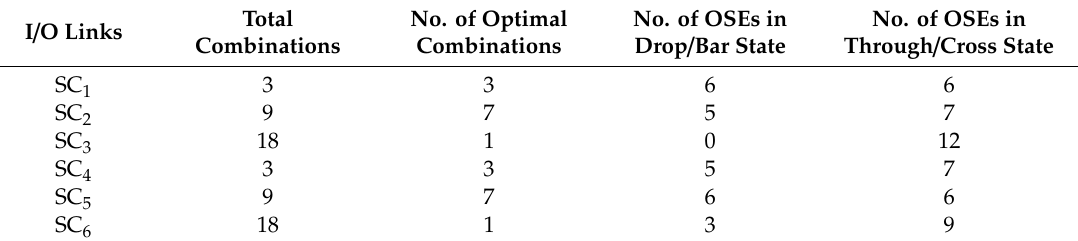
Table 7. Analysis of optimal switching combinations in optimized HCROS.